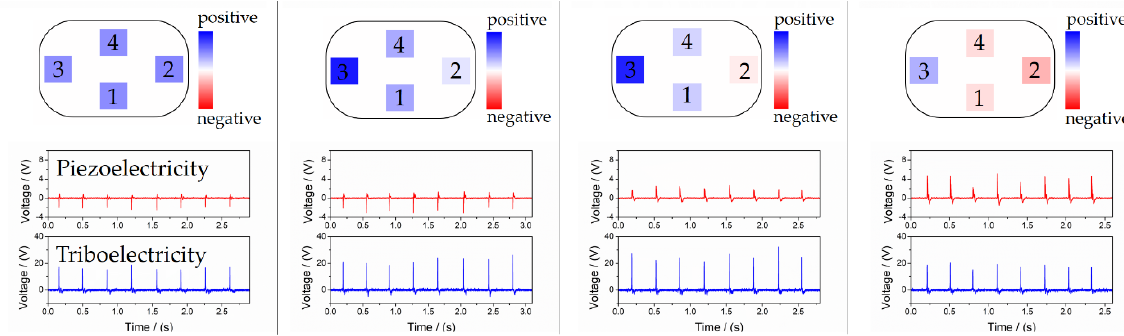
Figure 6. Analysis of specific response behaviors to terrain recognition. Tri-signal generated from hitting different inclinations under vertical force, including: ( a ) 0, ( b ) 15, ( c ) 30, and ( d ) 45 ◦ .